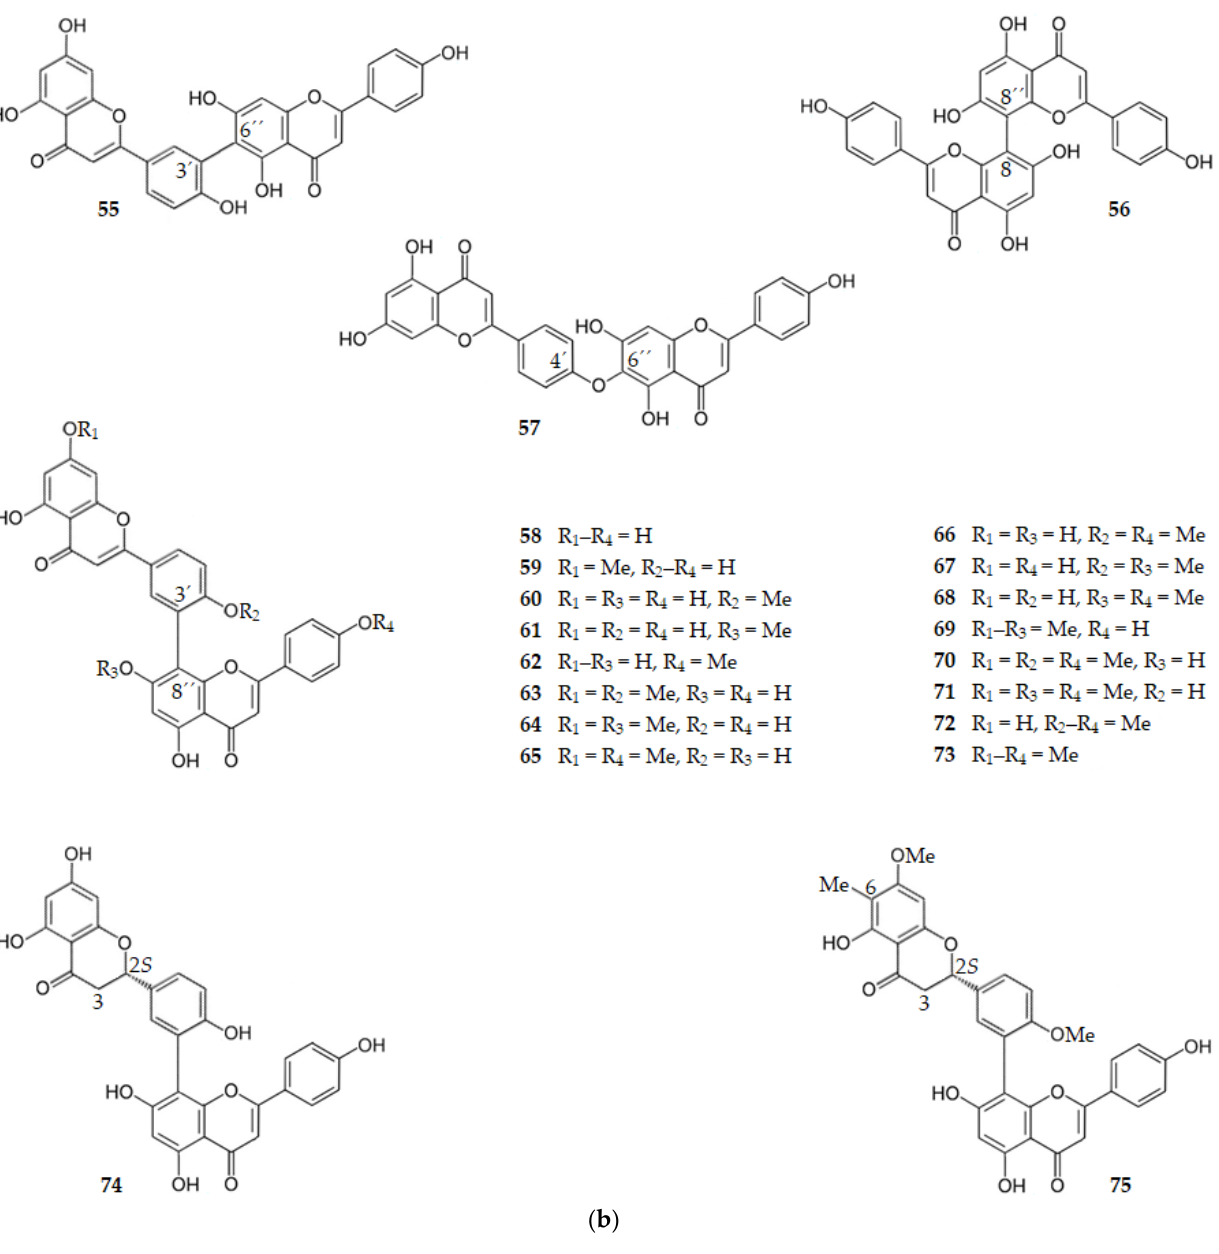
Figure 7. ( a) Structure of flavones that inhibit β -secretase and of the inactive flavones 44 and 45 . ( b ) Structure of flavones that inhibit β -secretase and of the inactive flavones 55 – 57 and 67 – 73 .